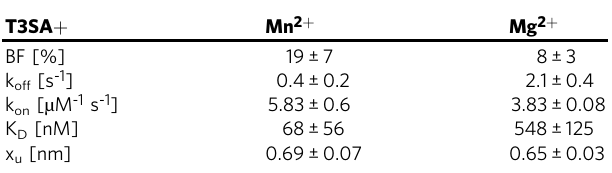
Table 1 Comparison of kinetic and thermodynamic parameters describing T3SA + virion- β 1 integrin interaction in the presence of either Mn 2 + or Mg 2 +